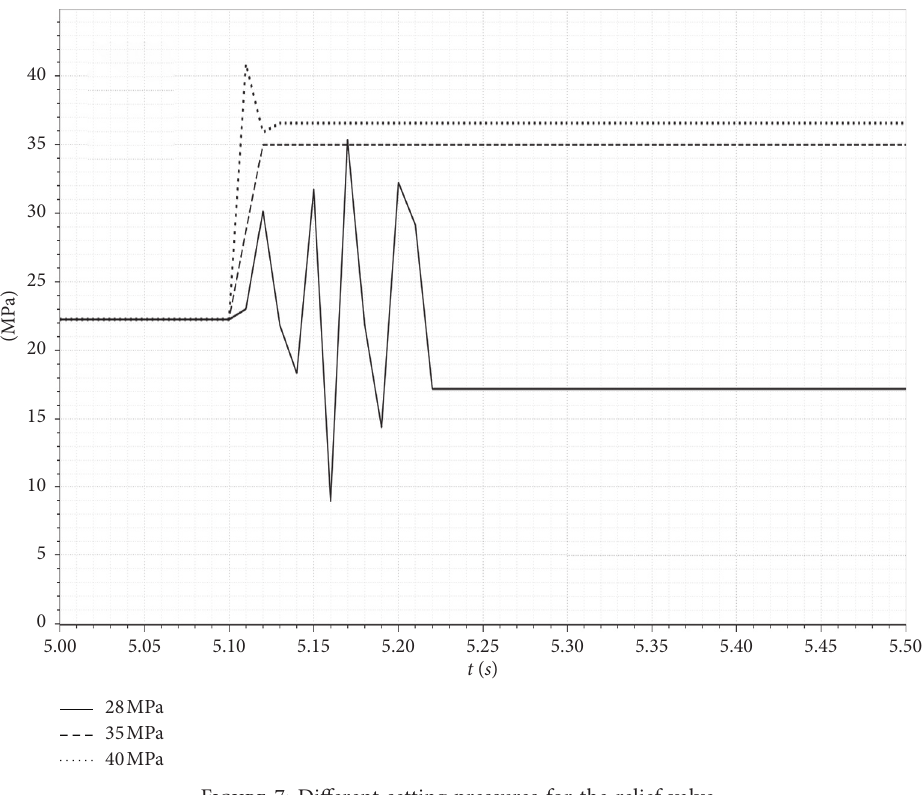
Figure 7: Different setting pressures for the relief valve.